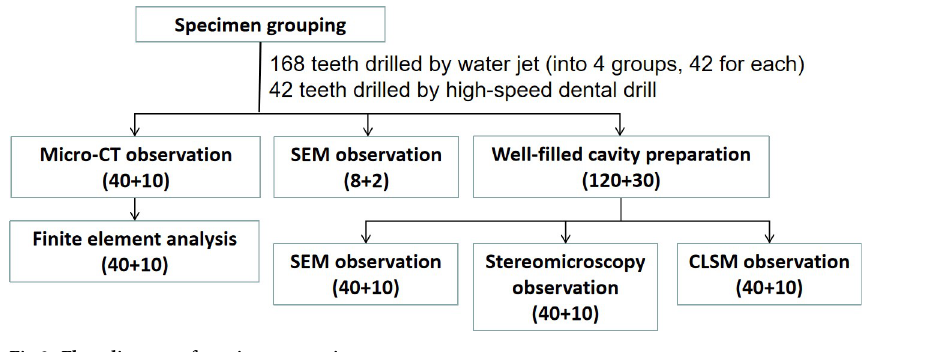
Fig 2. Flow diagram of specimen